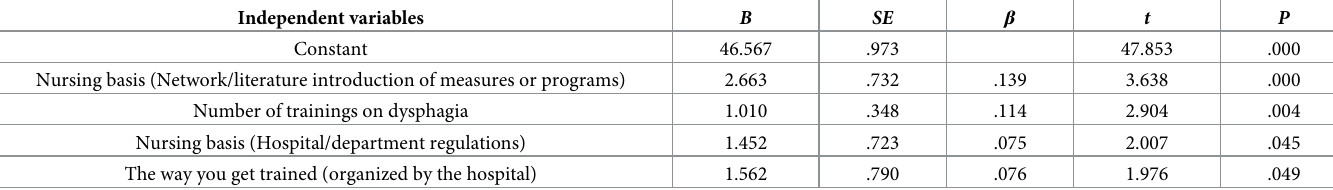
Table 6. Regression analysis of practice of neurological nurses in dysphagia.